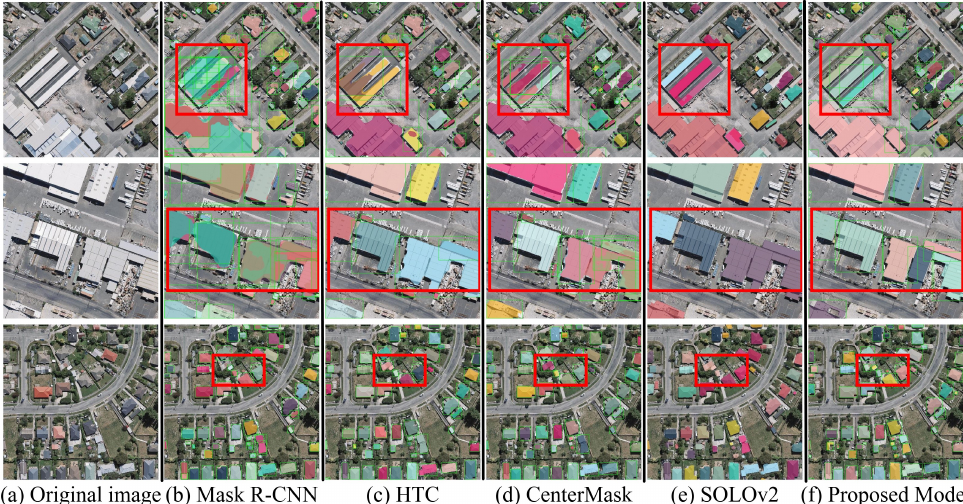
Figure 10. Visualized results of building instance extraction using the WHU aerial image dataset: ( a ) the original remote sensing imagery, ( b ) Mask R-CNN, ( c ) HTC, ( d ) CenterMask, ( e ) SOLOv2, ( f ) Proposed